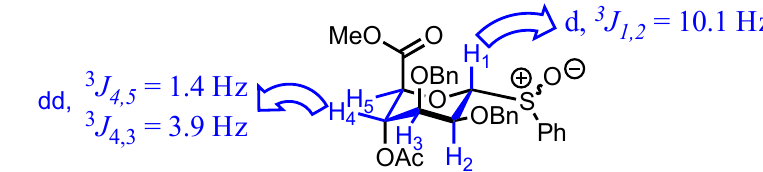
Figure 1. Indication of 1 C 4 conformation for ( 3 ) using 1 H NMR coupling constant data.